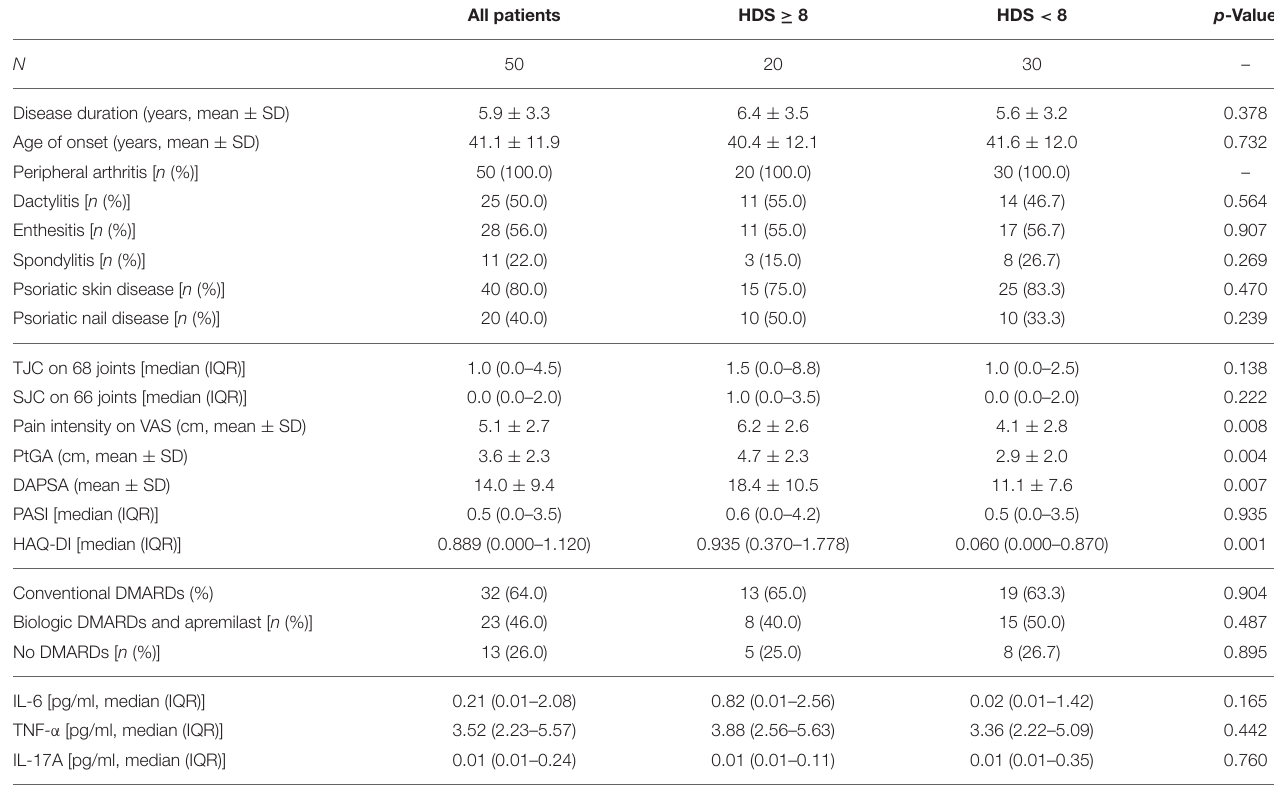
TABLE 1 | Clinical features of the enrolled PsA patients.